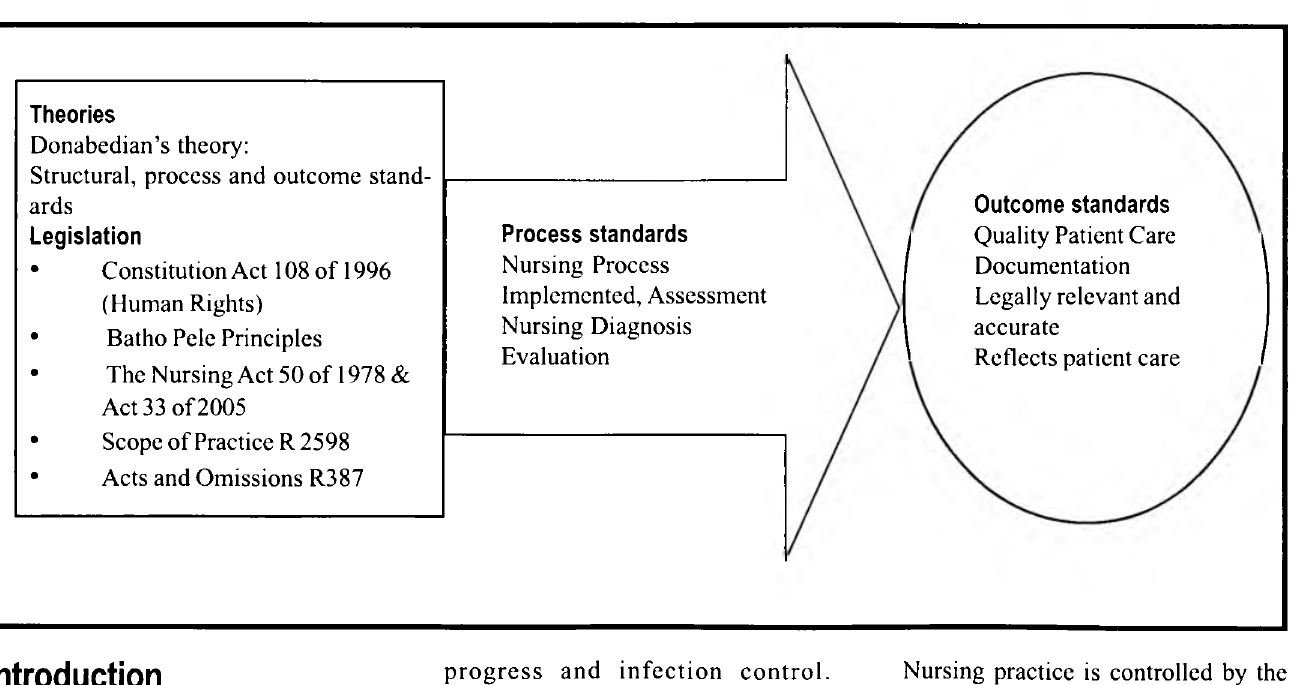
Figure 1: Conceptual framework for this study based on Donabedian’s